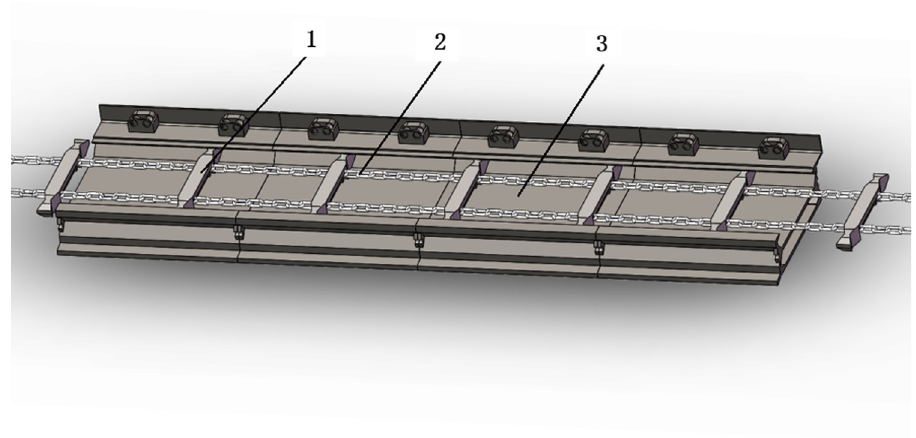
Fig 1. Assembly scheme of the middle trough of the scraper conveyor: 1-scraper, 2-chain, and 3-middle trough.